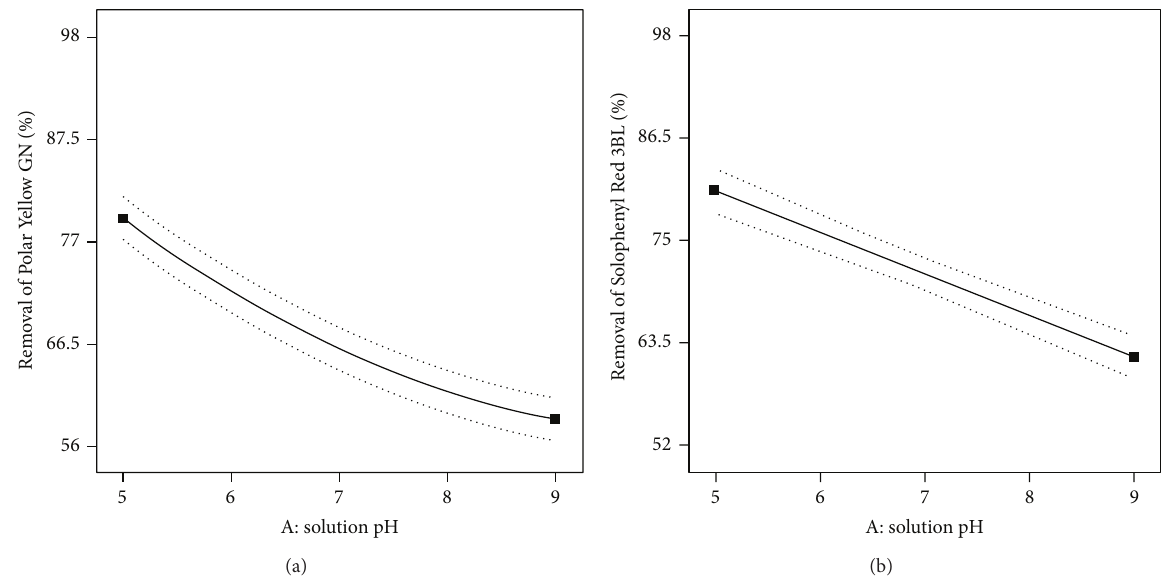
Figure 6: Effect of pH on the removal of acidic (Polar Yellow GN) and direct dyes (Solophenyl Red 3BL).